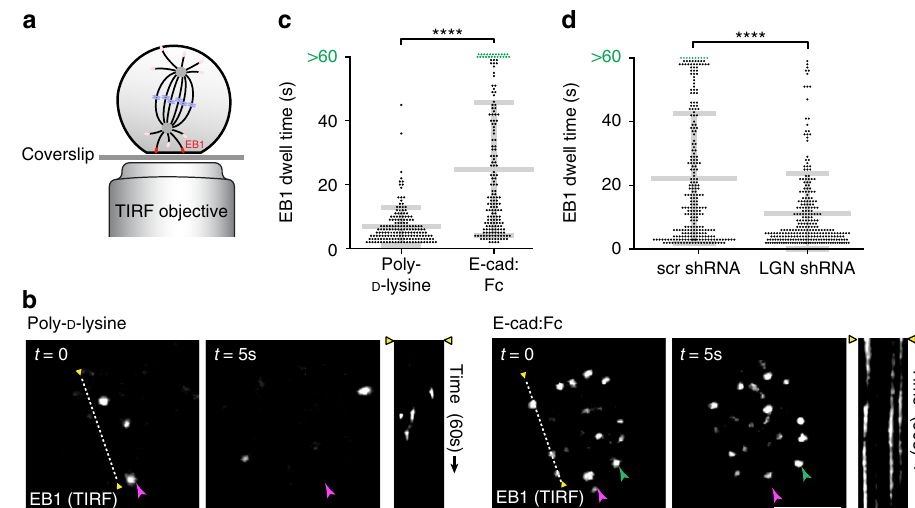
Figure 6 | E-cadherin adhesions stabilize cortical astral microtubule associations. ( a , b ) TIRF microscopy imaging of mRFP-EB1-marked astral microtubules at the basal membrane of MDCK cells adhering to poly-D-lysine or E-cad:Fc-coated surfaces. The kymograph shows the duration of basal mRFP-EB1 events in a 60s period along the indicated dotted line. Purple and green arrowheads indicate dynamic ( o 5s duration) and stable ( 4 5s duration) EB1 puncta, respectively. ( c ) Quantification of dwell times of EB1 puncta at the basal membrane of mitotic MDCK cells adhering to poly- D -lysine or E-cad:Fc-coated surfaces ( n ¼ 14 cells). ( d ) Quantification of the dwell times of EB1 puncta at the basal membrane of mitotic MDCK cells, expressing scrambled control (scr) or LGN shRNA, adhering to E-cad:Fc-coated surfaces ( n ¼ 11 cells). Scale bars, 5 m m. Quantified data were pooled from three independent experiments; grey bars show mean ± s.d. **** P o 0.0001 using Mann–Whitney